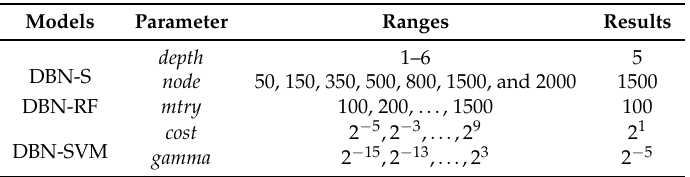
Table 4. Parameter optimization results for deep features-based models. DBN-S: deep belief network (DBN) with softmax classifier. DBN-RF: the fused model of DBN and random forest. DBN-SVM: the fused model of DBN and support vector machine.